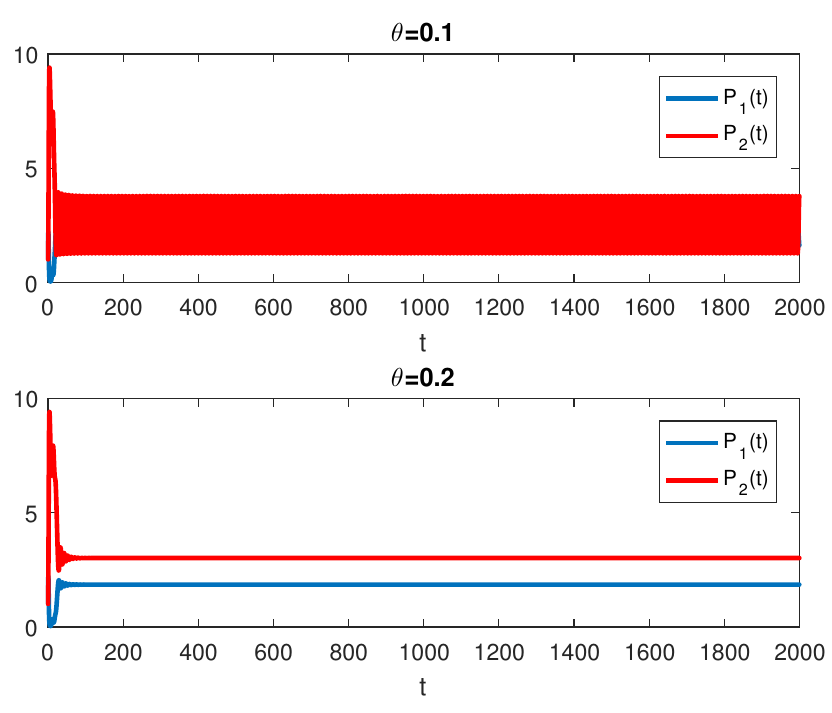
Figure 2. The RPW system (1) with θ = 0.1 and θ = 0.2.